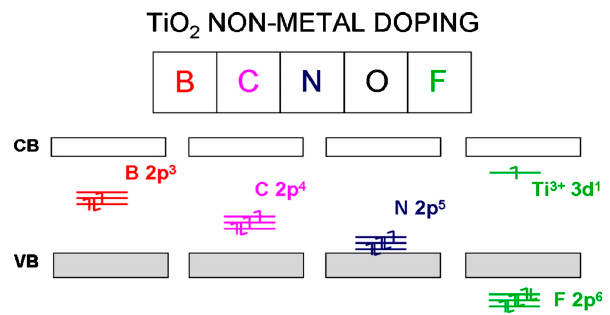
Figure 8. Electronic band structure of titania due to non-metal doping. CB and VB represent conduction band and valence band, respectively. Reproduced with permission from [160]. Copyright Elsevier, 2013.